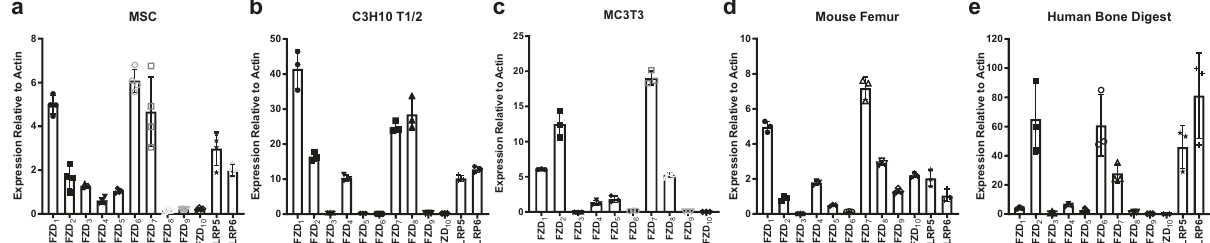
Fig. 1 Wnt signaling components expression analysis from various cells and species. Fzd 1 – 10 , along with Lrp5, and Lrp6 mRNA expression in a mesenchymal stem cells (MSC), b C3H10T1/2 cells, c MC3T3 cells, d mouse femur, and e human cancellous femoral head quanti fi ed by qPCR and normalized by the housekeeping gene Actin. Bars represent means ± SD. d n = 3 mice and e n = 3 human femoral